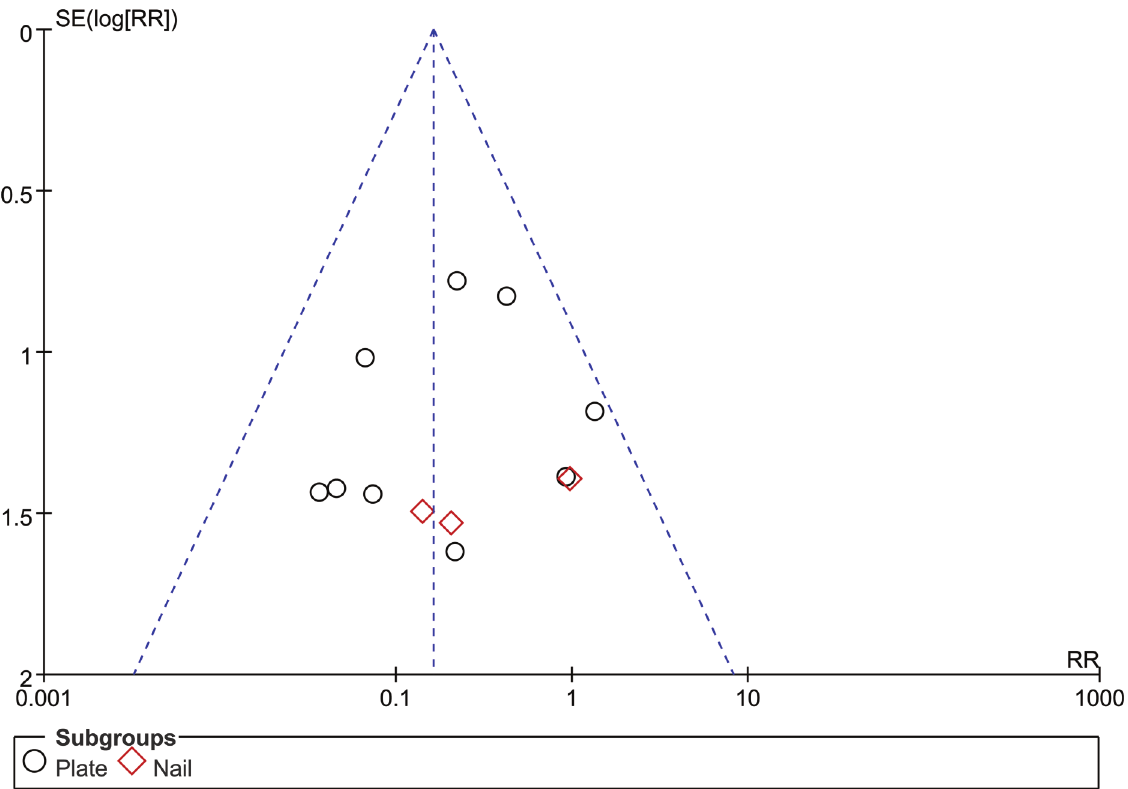
Figure 5 - Funnel plot of detection of publication